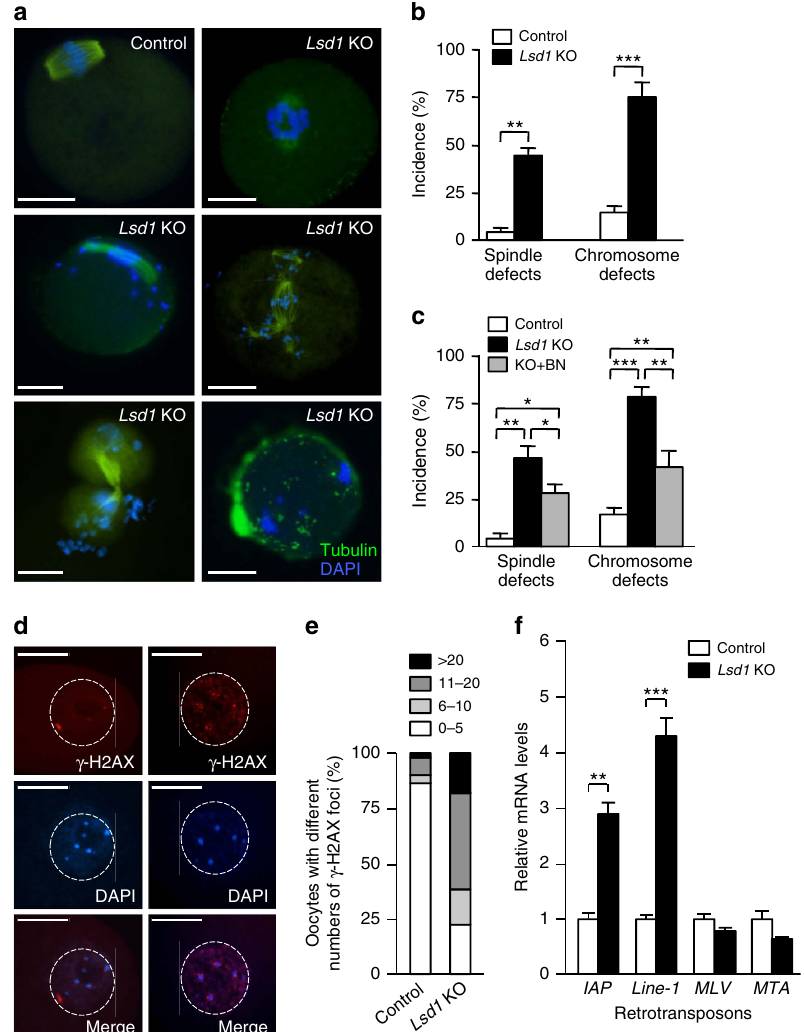
Figure 6 NATURE COMMUNICATIONS|7:11467|DOI: